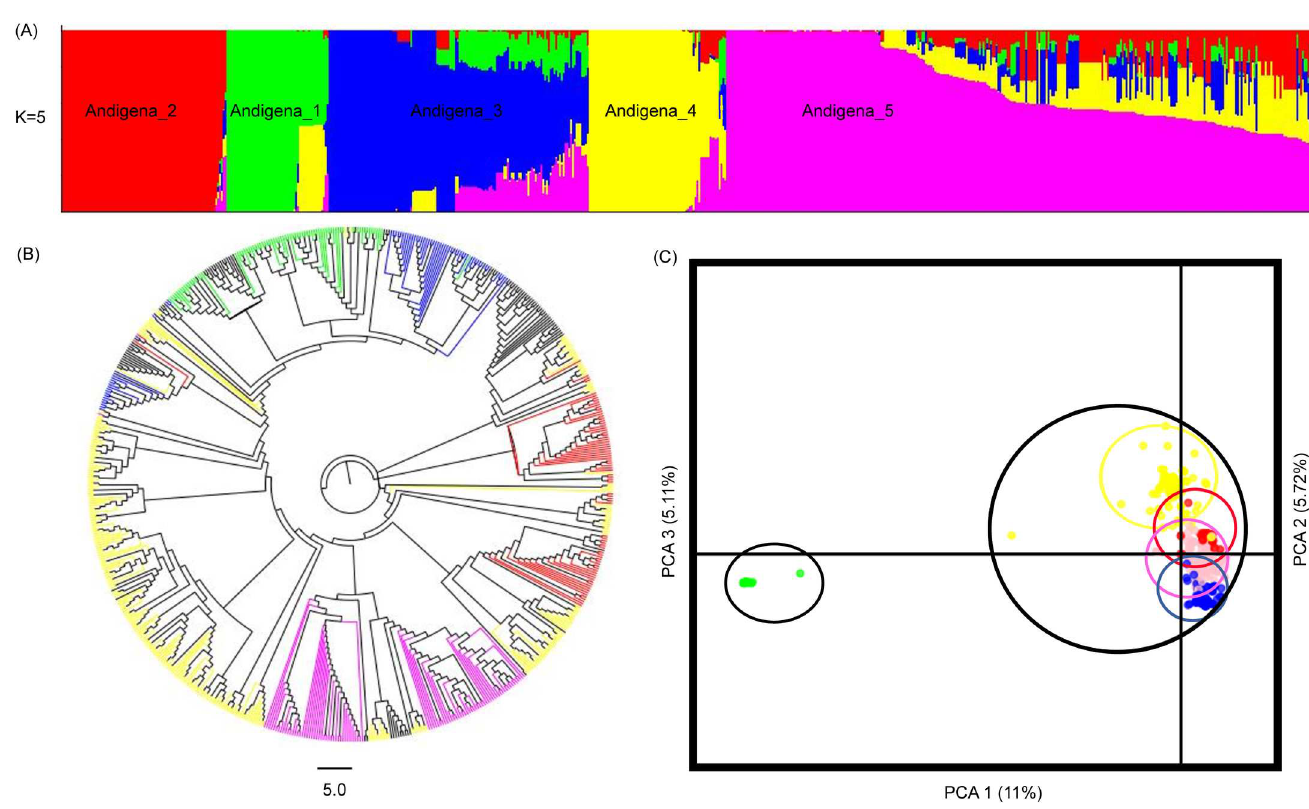
Fig 4. Population structure of 676 tetraploid accessions (Andigena population) of Colombian Central Collection of S . tuberosum . (A) ClusteringStructure analysis. (B) NJ-tree basedon Nei´s geneticdistance. (C) Discriminant Analysis